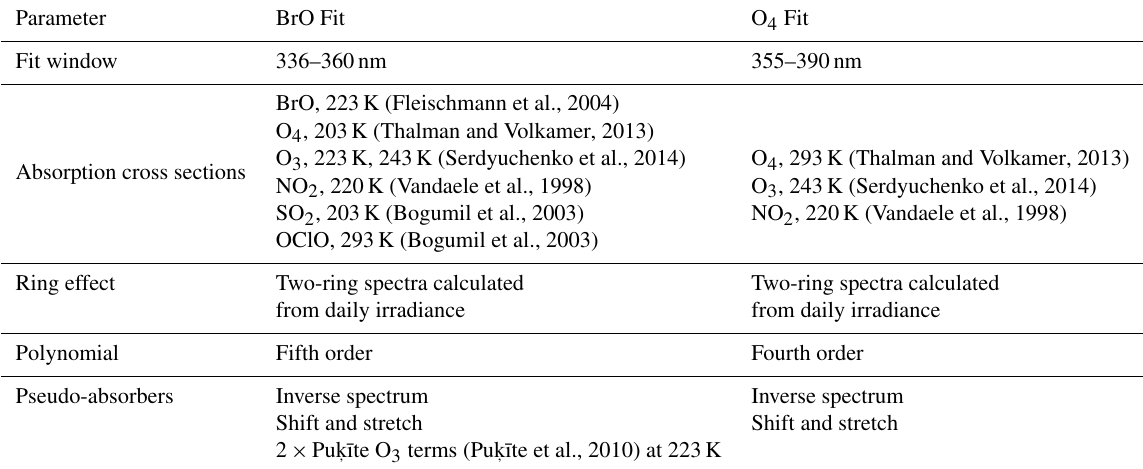
Table 2. DOAS fit settings. Parameter Fit